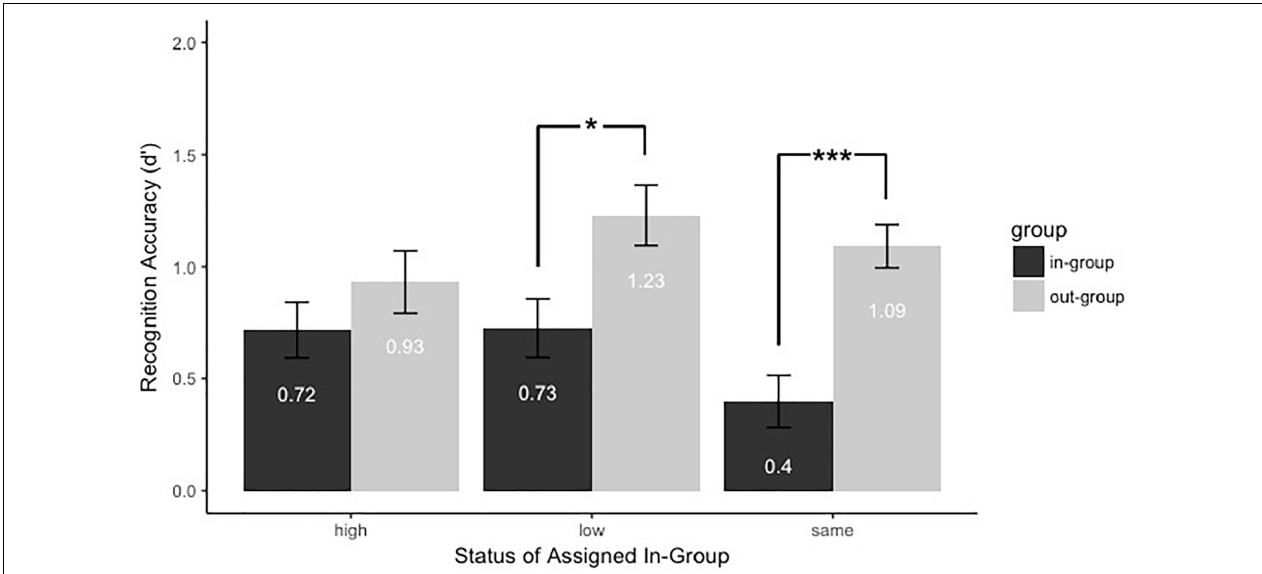
FIGURE 4 | Recognition accuracy (d’) for faces assigned to different groups with high, low, or same power. Black bars refer to in-group members, and gray bars refer to out-group members. Error bars represent standard errors (* p < 0.05 and *** p < 0.001).